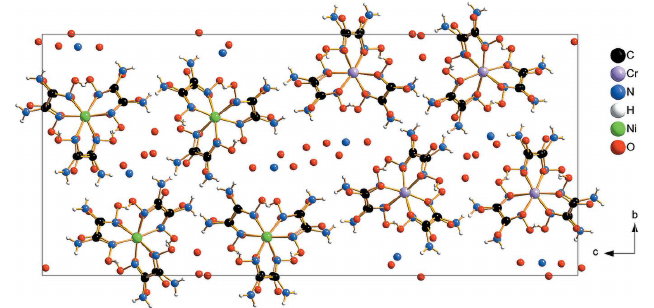
Figure 3 The molecular components of the asymmetric unit of ( I ), showing the atom-numbering scheme and displacement ellipsoids at the 50% probability